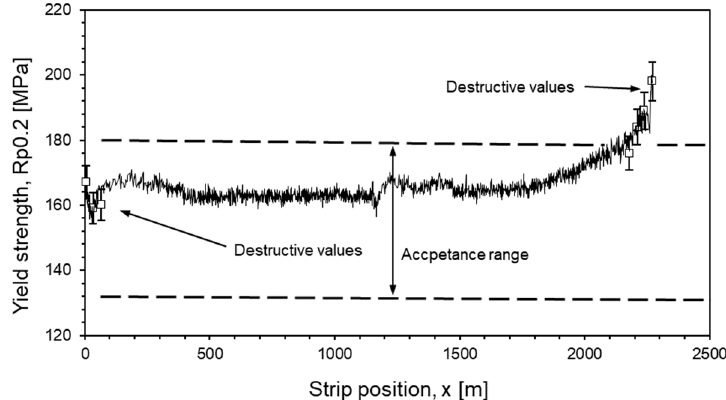
Figure 7. Inline measurement of yield strength Rp0.2 in a coil of 2300 m in length. Destructive measurements of Rp0.2 at the beginning and at the end of the strip are also shown as white squares with error bars.